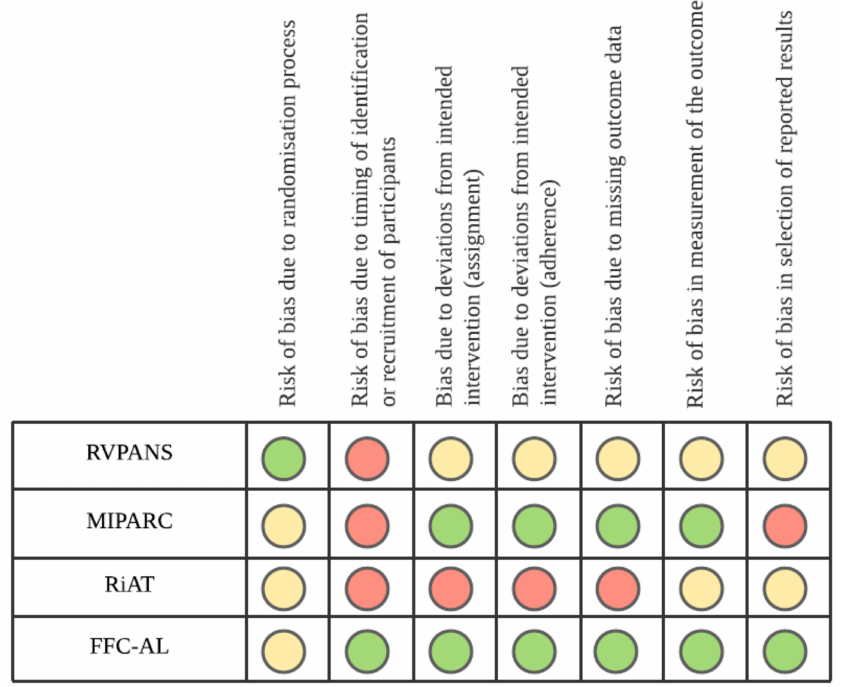
Figure 2. RoB2 (Risk of Bias 2 ) assessment of bias for cluster RCTs (randomized controlled trials). Retirement Village Physical Activity and Nutrition for Seniors (RVPANS); Multilevel Intervention for Physical Activity in Retirement Communities (MIPARC); Residents in Action Trial (RiAT); Function Focused Care—Assisted Living (FFC-AL). Green = Low Risk of bias; Yellow = Unclear Risk of bias; Red = High Risk of